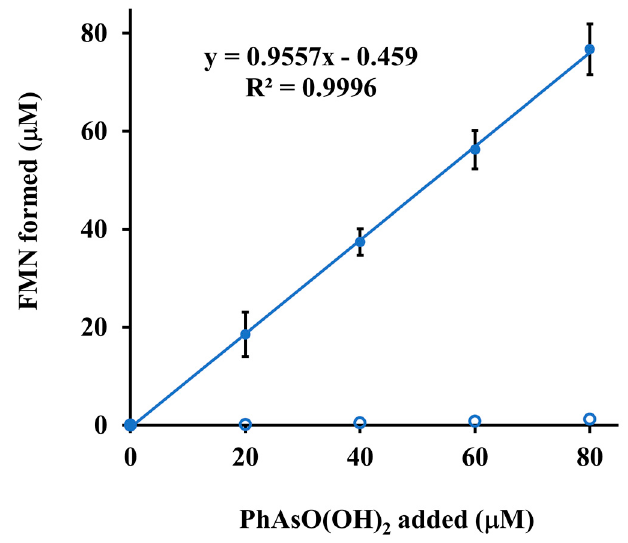
Figure 3. ArsH-catalyzed oxidation of reduced FMN by phenylarsonic acid. A sealed 1 cm spectrophotometric cuvette contained 1 mL of argon-purged 0.1 M sodium phosphate buffer, pH 7.0, with 100 µ M FMN. 205 nM ArsH was either present (solid circles) or absent (open circles). After reduction of FMN with dithionite, measurement was performed by adding successive 20 µ M portions of phenylarsonic acid. The resulting absorbance at 450 nm was read after attaining a constant level (within about 5 min). All A 450 readings were corrected by subtracting the initial absorbance and converted to concentrations using an absorbance coefficient of 12,200 M − 1 cm − 1 . The value of the slope of the straight line fitted to the data points indicates that the stoichiometric ratio of FMN produced to phenylarsonic acid added is 1:1. Each data point is mean of triplicate determinations ± SD.